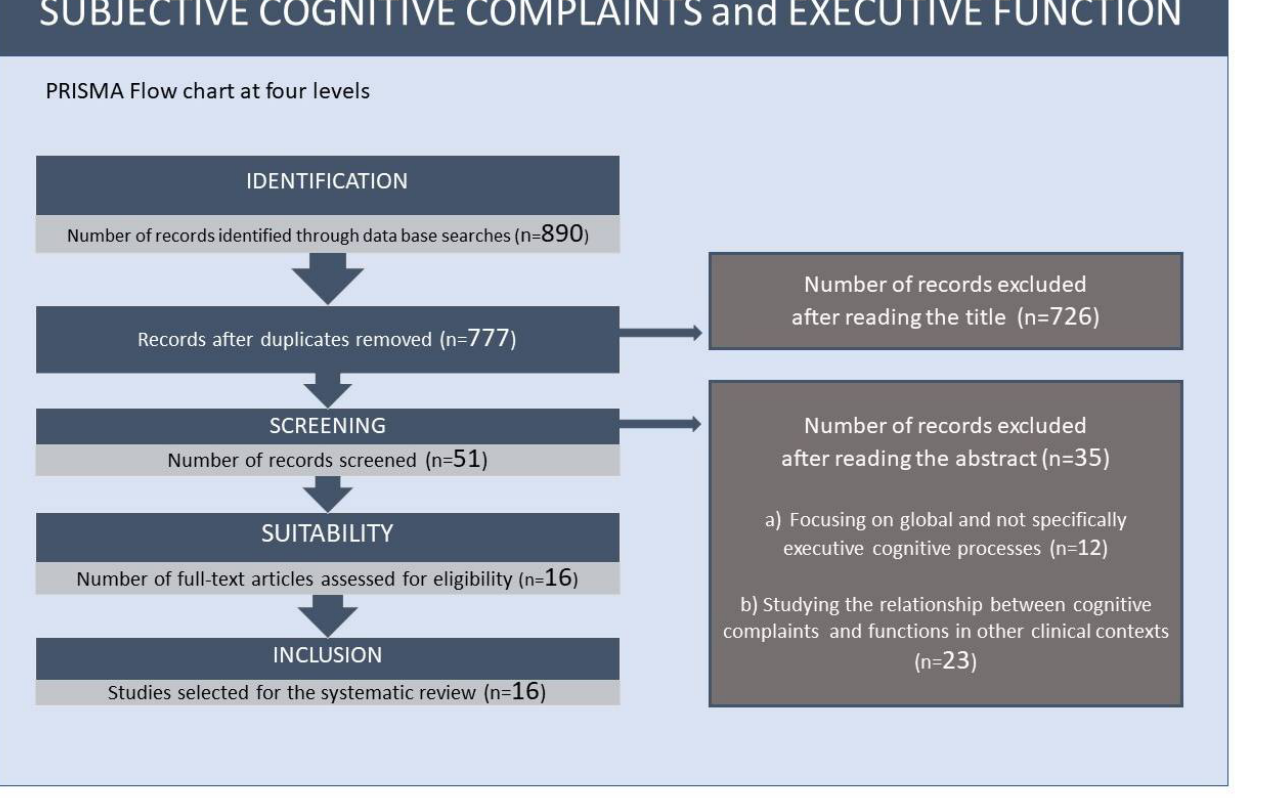
Figure 1. Flow chart of the systematic review on subjective cognitive complaints and executive func- tions.